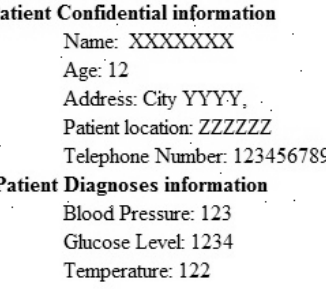
Figure 6. Extracted patient information.